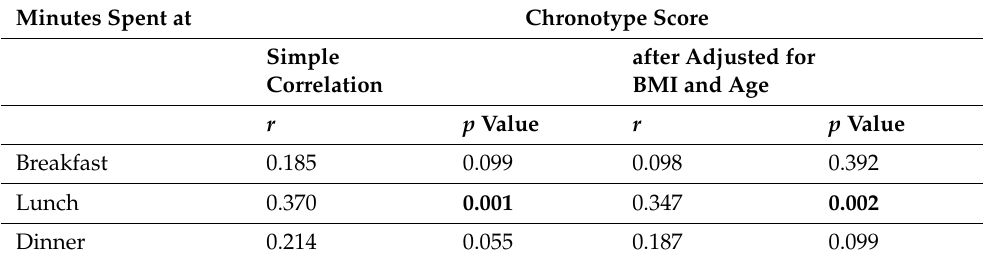
Table 5. Correlations between chronotype score and eating speed at the main meals. Minutes Spent at Chronotype Score Simple after Adjusted for Correlation BMI and Age r p Value r p Value Breakfast 0.185 0.099 0.098 0.392 Lunch 0.370 0.001 0.347 0.002 Dinner 0.214 0.055 0.187